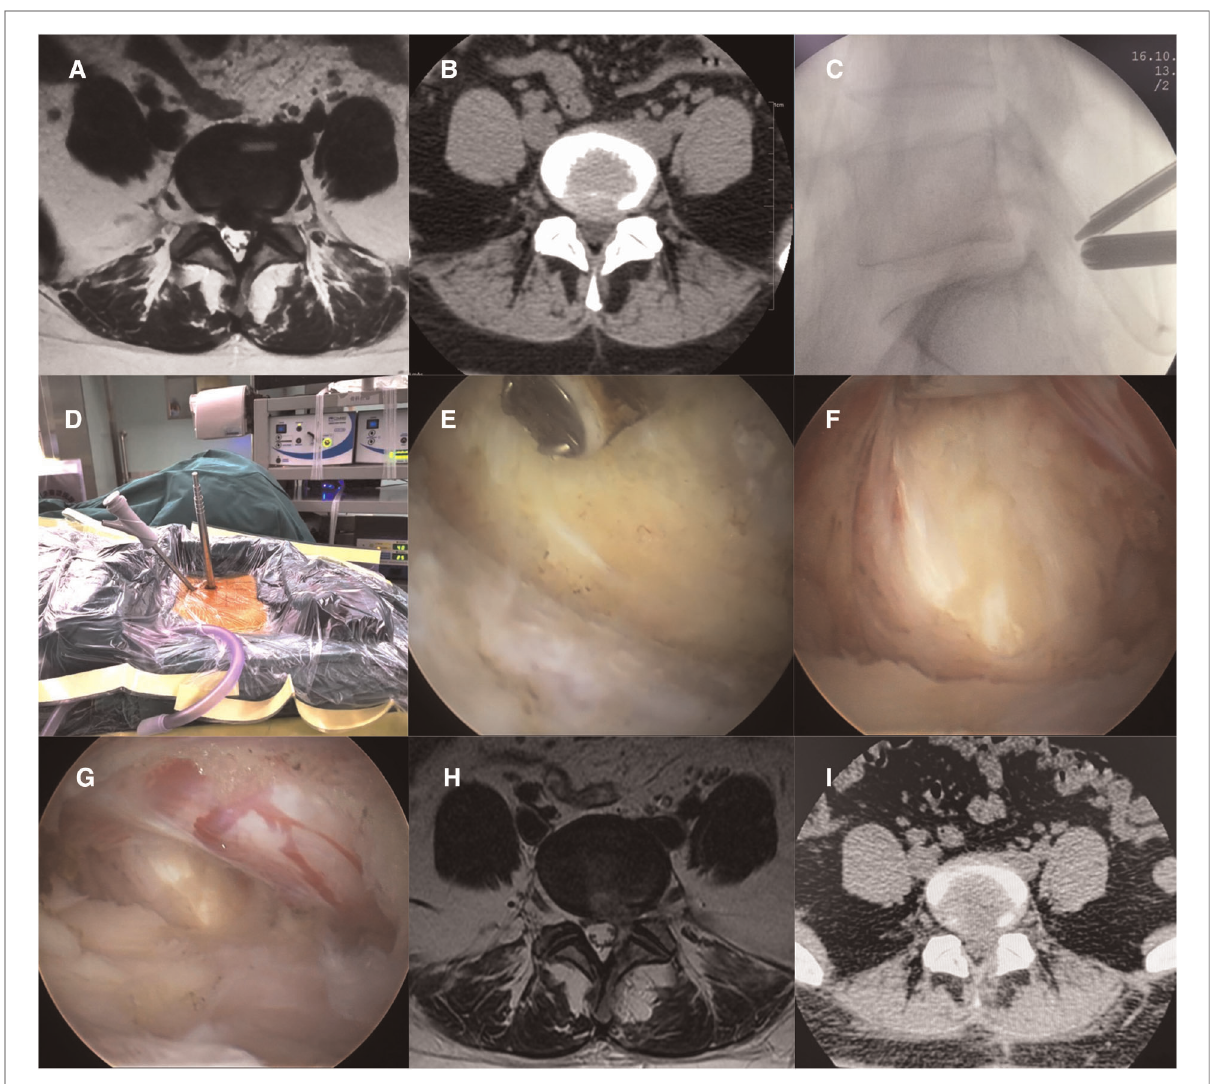
FIGURE 1 ( A,B ) Preoperative patient MRI and CT revealing L5/S1 disc herniation. ( C,D ) Intraoperative localization of UBE/BESS and establishment of proximal and distal access. ( E ) Establishment of a working space to expose the interlaminar window. ( F ) Medial retraction of the nerve root and exposure of the herniated disc. ( G ) Loosened nerve roots after disc removal. (H, I) Postoperative patient MRI and CT showed that the L5/S1 herniated disc had been